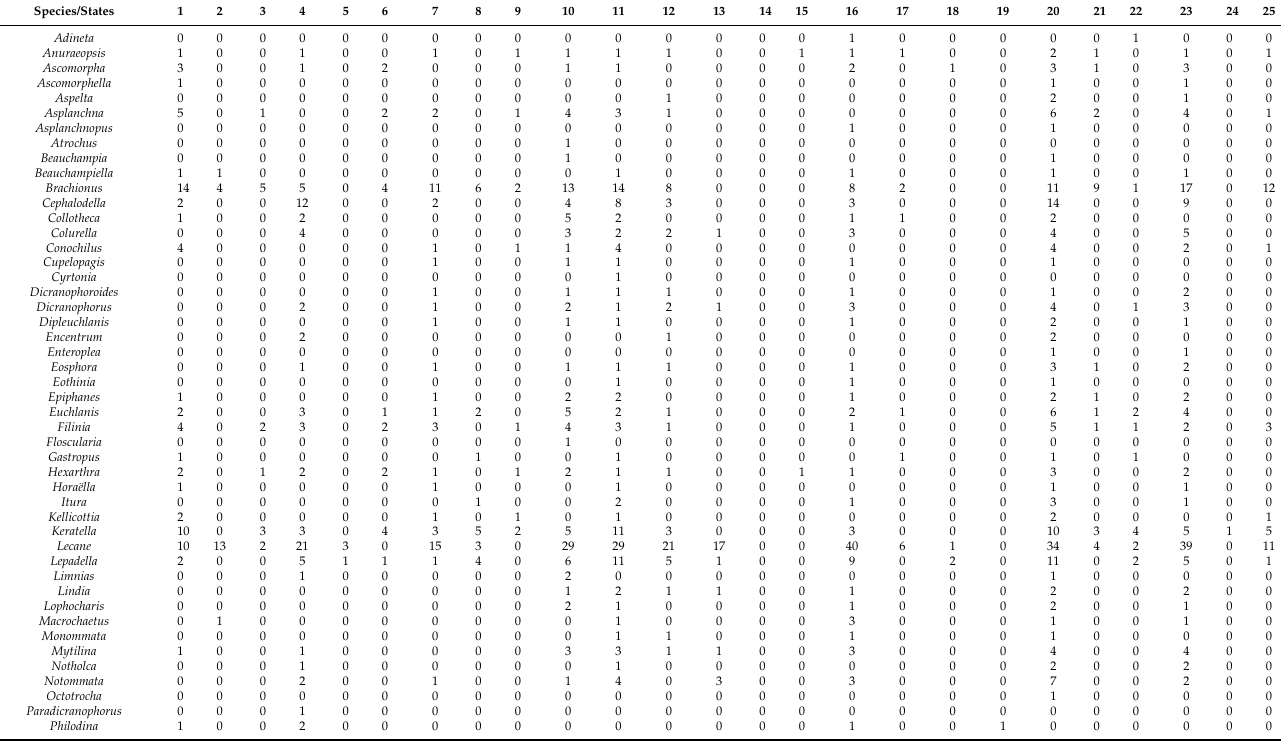
Table 3. Number of genera and species of rotifers reported from different States of Mexico. The states are represented by bold numbers. 1: Aguascalientes, 2: Campeche, 3: Chiapas, 4: Chihuahua, 5: Colima, 6: Guanajuato, 7: Guerrero, 8: Hidalgo, 9: Jalisco, 10: Mexico City, 11: Michoacan, 12: Morelos, 13: Nayarit, 14: Oaxaca, 15: Puebla, 16: Quintana Roo, 17: San Luis Potosi, 18: Sinaloa, 19: Sonora, 20: State of Mexico, 21: Tabasco, 22: Tlaxcala, 23: Veracruz, 24: Yucat á n, 25: Zacatecas. Other states do not have published records of rotifers, and these were not included.